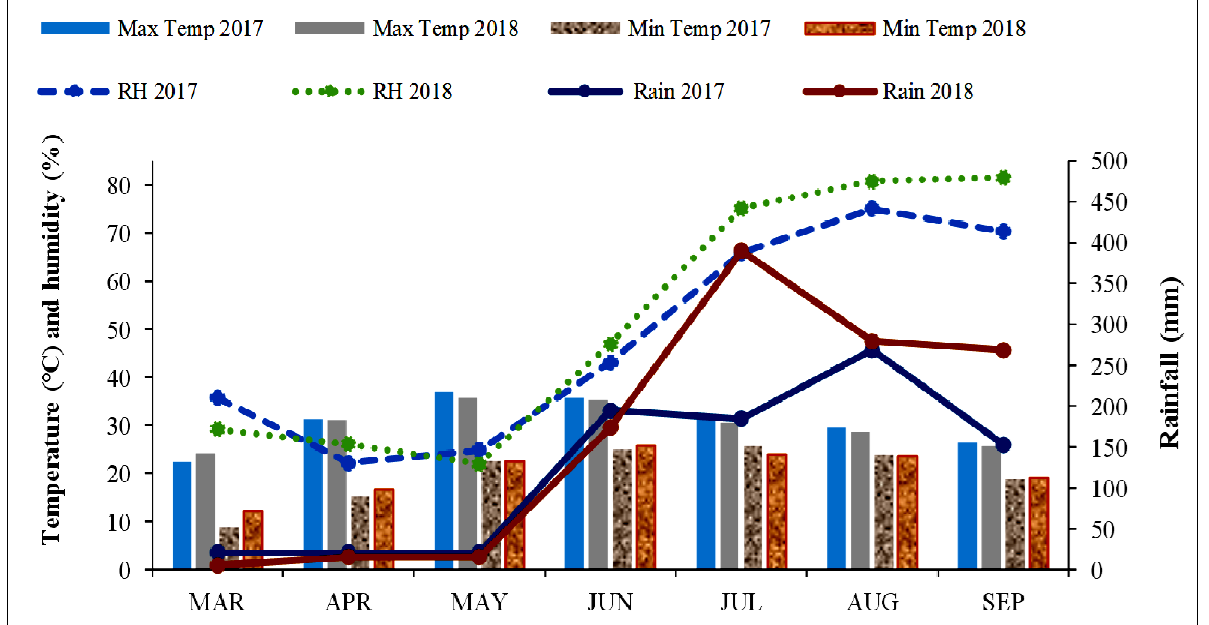
Figure 1. Agrometeorological data during the crop period (2017 and 2018). The maximum temperatures during both crop seasons varied from 22.4 to 36.9 °C and 24.3 to 35.8 °C, respectively. However, the minimum temperatures varied from 8.9 to 25.7 °C and 12.2 to 25.7 °C during 2017 and 2018, respectively. The average relative humidity in 2017 ranged from 22.3 to 75.1% and in the year 2018 it varied from 22 to 81.6%. The total rainfall rates during the crop season (March to September) were 865 mm and 1150 mm in 2017 and 2018, respectively. The rainfall from March to June decreased during 2018 in comparison to 2017, whereas the next three months (July–September) received excess rain with higher relative humidity, which damaged the crops and caused higher levels of disease incidence. According to the USDA Soil Taxonomy, the soils in the study area are classified as Inceptisol soils. The standard methods were followed to determine the pH, EC, and OC values, which were found to be 6.5, 0.14 dSm − 1 , and 2.05 g kg − 1 , respectively [15,16]. The method proposed by Subbiah and Asija, the Olsen extractable P method, and the method proposed by Merwin and Peech were used to estimate the availability rates of N, P, and K to be 274.4 Kg ha − 1 , 55.2 Kg ha − 1 , and 331 Kg ha − 1 in the soil, respectively [17–19]. Additionally, the initial micronutrient levels of Zn, Cu, Fe, and Mn in the soil were 3.11 mg kg − 1 , 98.0 mg kg − 1 , 2.17 mg kg − 1 , and 10.32 mg kg − 1 , respectively [20], as calculated using the AAS instrument (Varian AA 240FS, LabX, 334 King Street, Midland, ON,